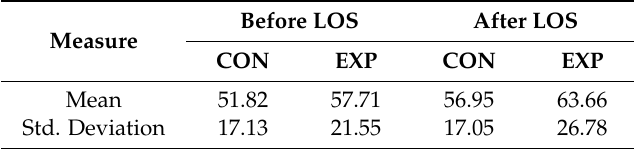
Table 3. Mean values and standard deviations of